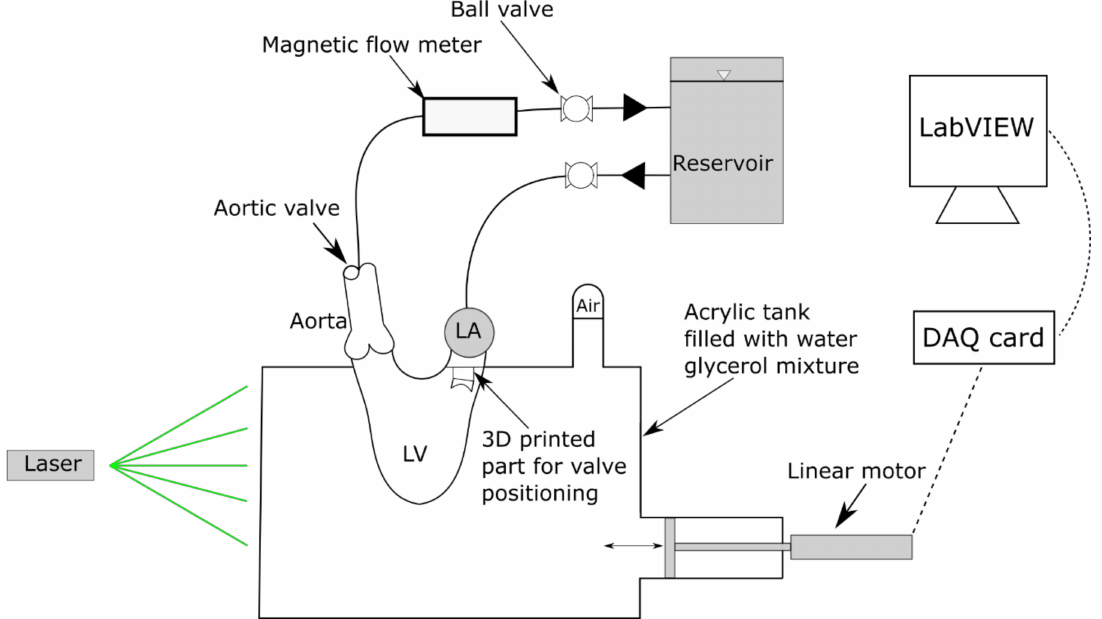
Figure 1. Schematic of the heart simulator used. Ball valves are used to regulate the pressure and flow rate throughout the system. Actuation of the system is done hydraulically via the linear motor. The camera is placed out of the page, orthogonal to the laser sheet, with the recording window being into the